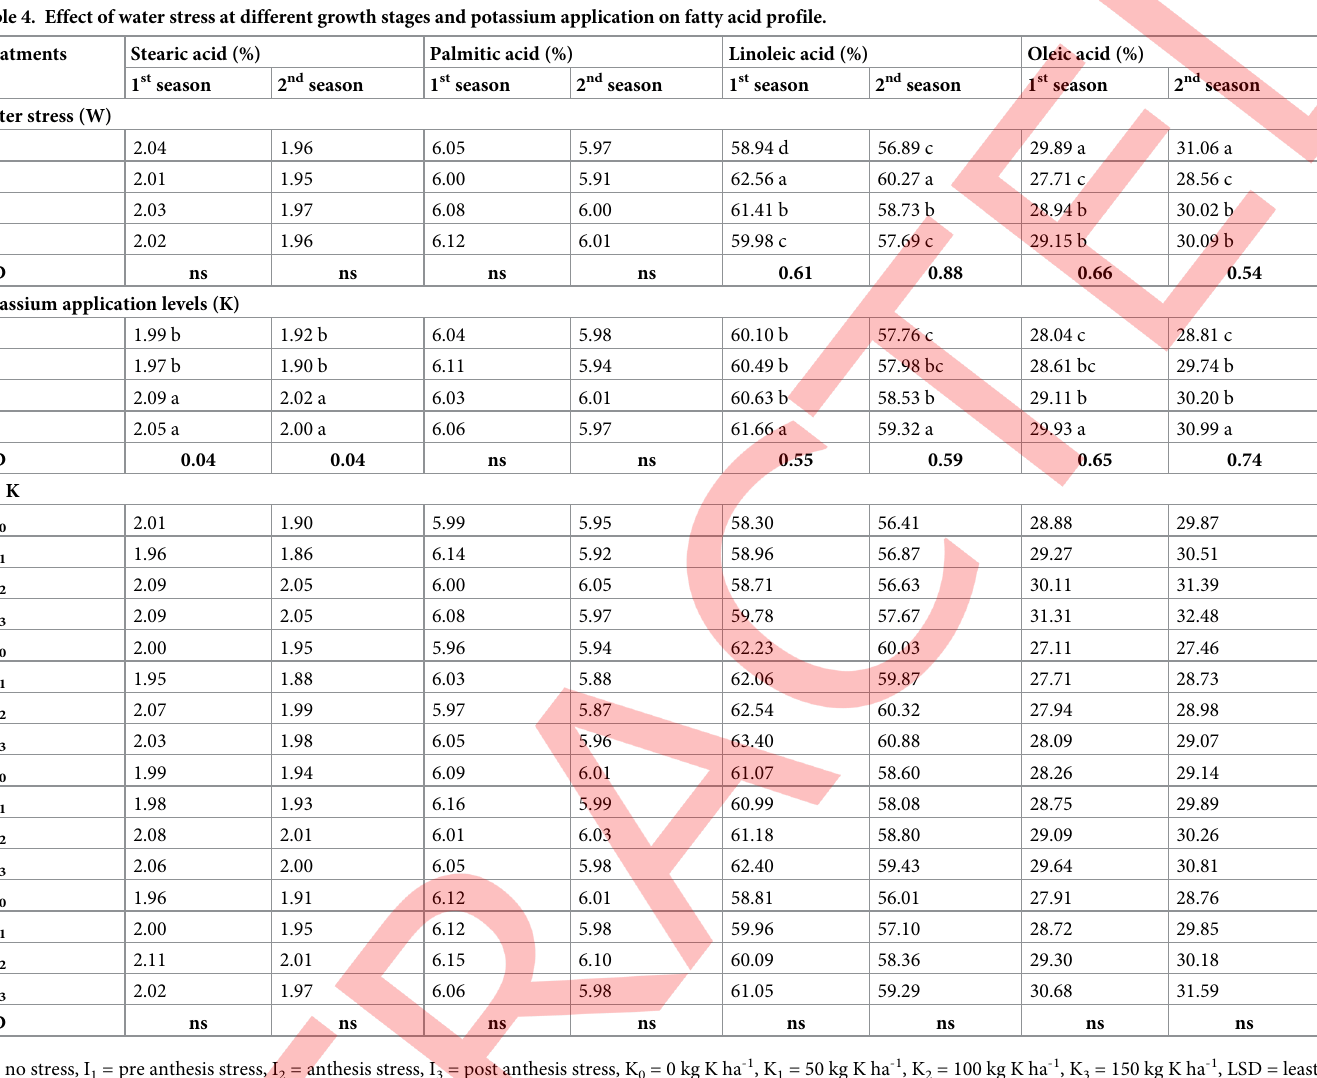
Table 4. Effect of water stress at different growth stages and potassium application on fatty acid profile. Treatments Stearic acid (%) Palmitic acid